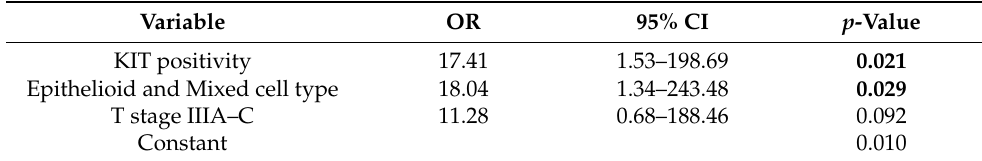
Table 5. Binary logistic regression for the relationship between M3, clinicopathologic characteristics, and selected IHC markers (significance in univariate analysis p <